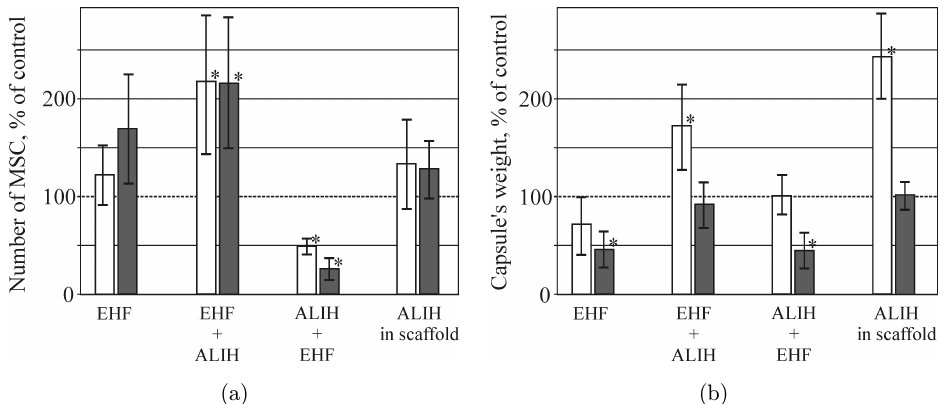
Fig. 4. (a) Number of MSCs per transplant and (b) dry weight of bone capsule within three months (open columns) and ¯ve months (full columns) after exposure to the physical factors. The asterisks indicate the results reliably di®ering from the controls ( p < 0 : 05 ; n (cid:5)